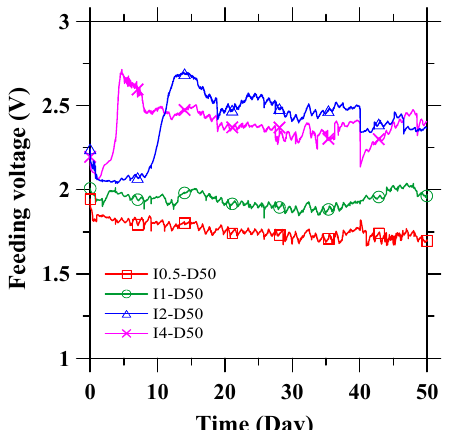
Figure 3. The feeding voltage between CFRP and stainless steel during galvanostatic anodic polarization process.